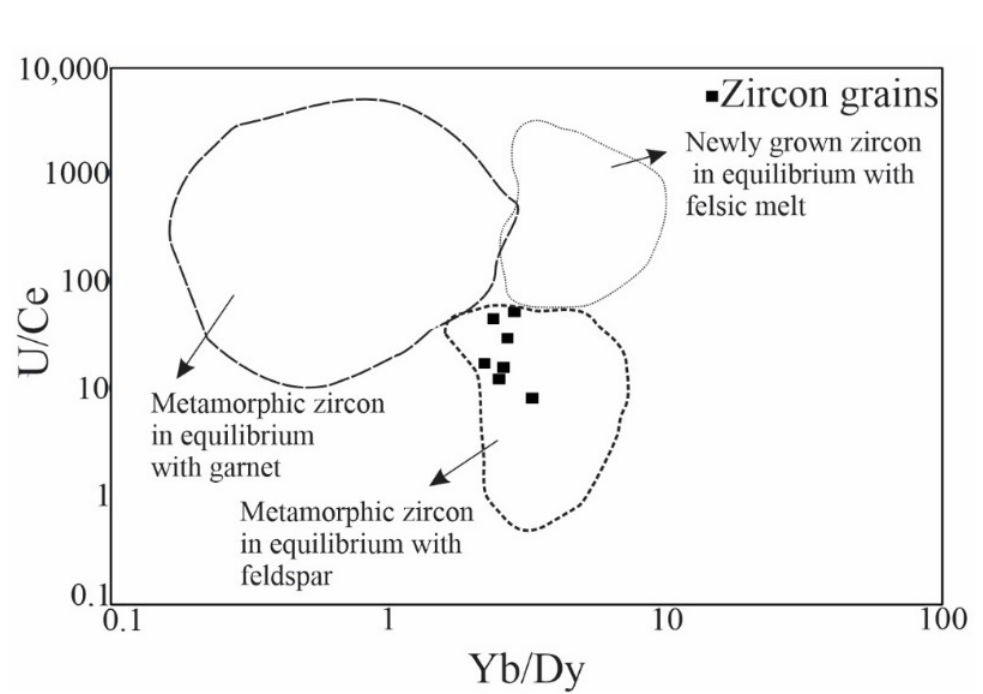
Figure 8. Yb/Dy vs. U/Ce variations in the zircons obtained from different samples of sand analysed